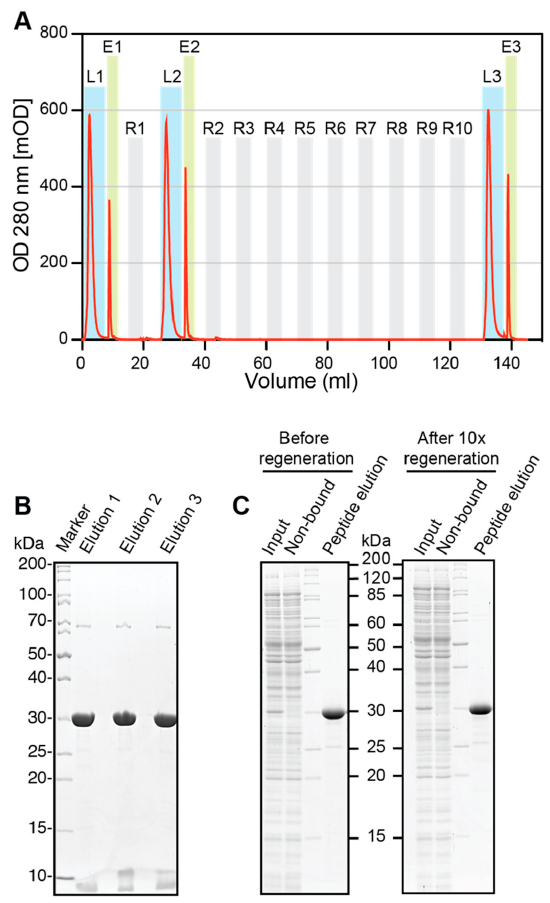
Figure 5. Regeneration of ALFA Selector CE under acidic conditions. ( A ): 0.5 mL of ALFA Selector CE was subjected to a first cycle of loading with ALFA-shGFP2 (L1) and competitive peptide elution (E1). The column was regenerated under acidic conditions using 100 mM glycine and 150 mM NaCl at pH 2.2 (R1) and re-equilibrated with PBS before starting a second cycle of loading and elution (L2 and E2). After 9 additional repeated regeneration/re-equilibration steps (R2–R10), the column was loaded and eluted a third time (L3, E3). The whole procedure was followed by recording the optical density at 280 nm (OD280; red curves). ( B ): Fractions for each elution step were collected, quantified and analyzed by SDS-PAGE and Coomassie staining. ( C ): Effect of regeneration on nonspecific background binding. Single-step affinity purification from E. coli lysate blended with shGFP2-ALFA was performed using ALFA Selector CE either before regeneration or after 10 cycles of regeneration with glycine, pH 2.2 (left and right panels, respectively). The experiment was essentially performed as described for Figure